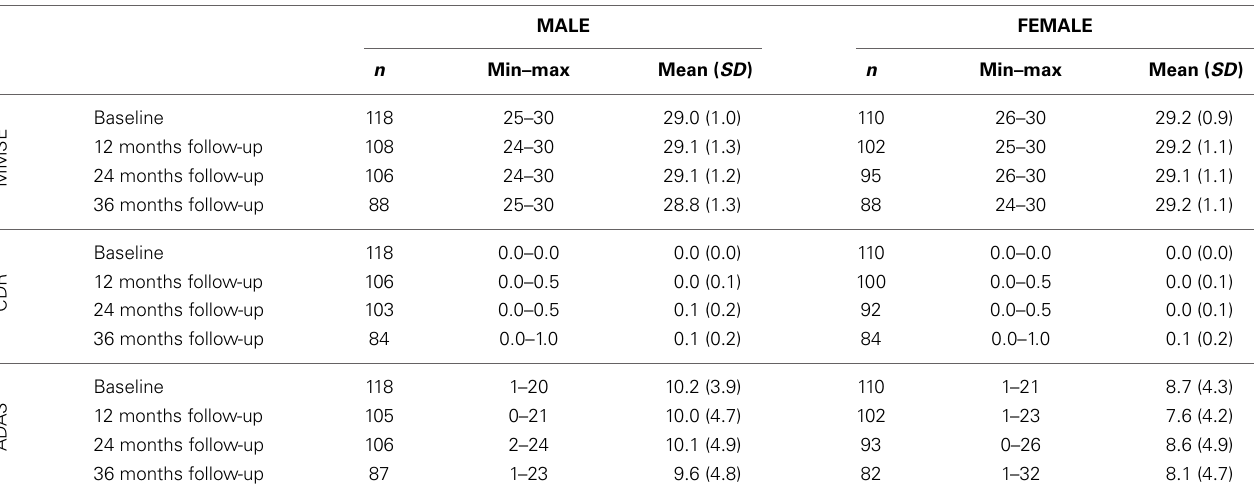
Table 2 | Cognitive characteristics in male and female test